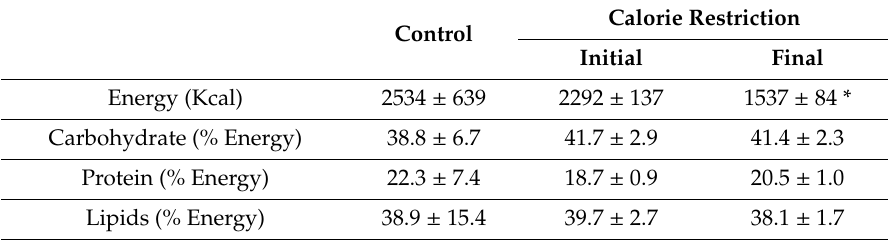
Table 1. Diet characteristics before and after a nutritional intervention with calorie